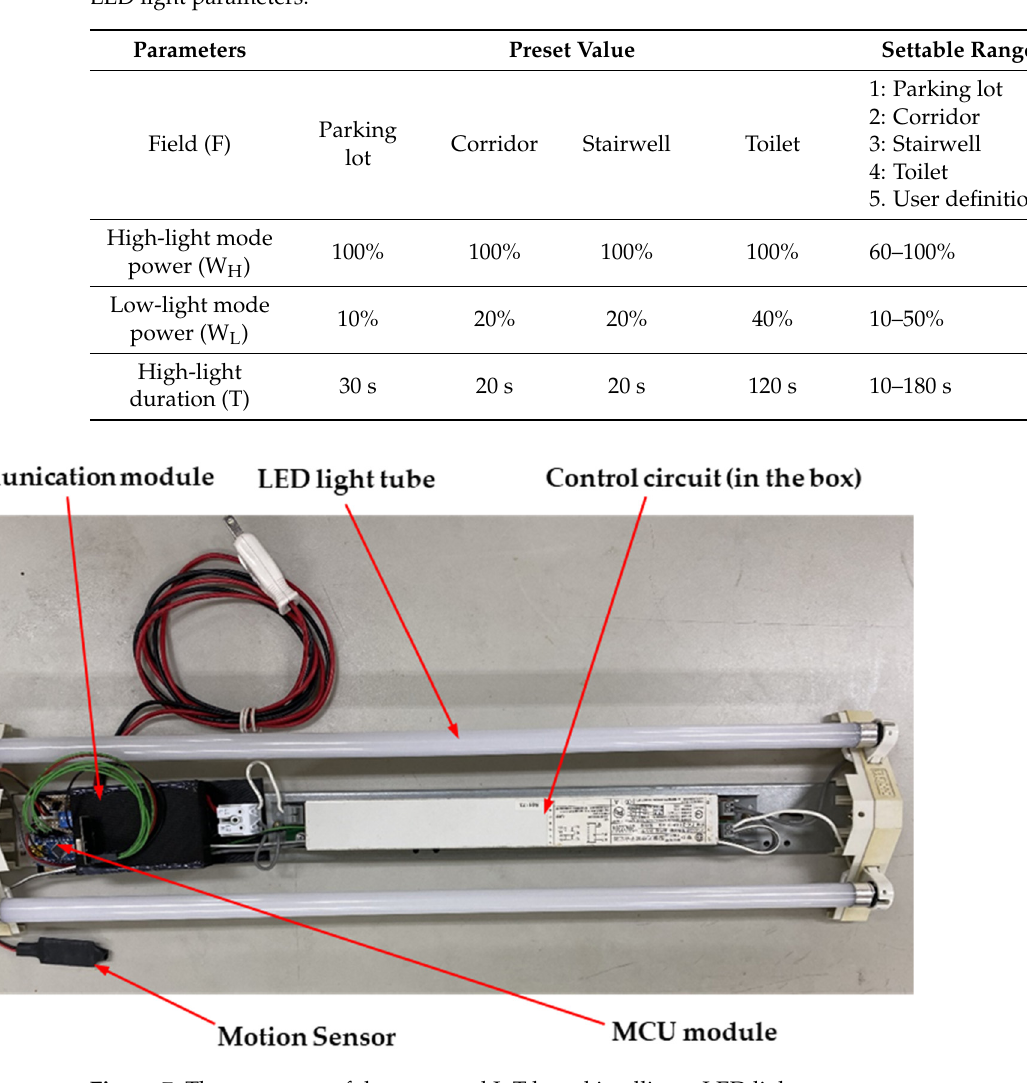
Figure 7. The prototype of the proposed IoT-based intelligent LED light. Table 4. An example of the preset values and settable ranges of the proposed IoT-based intelligent LED light parameters.